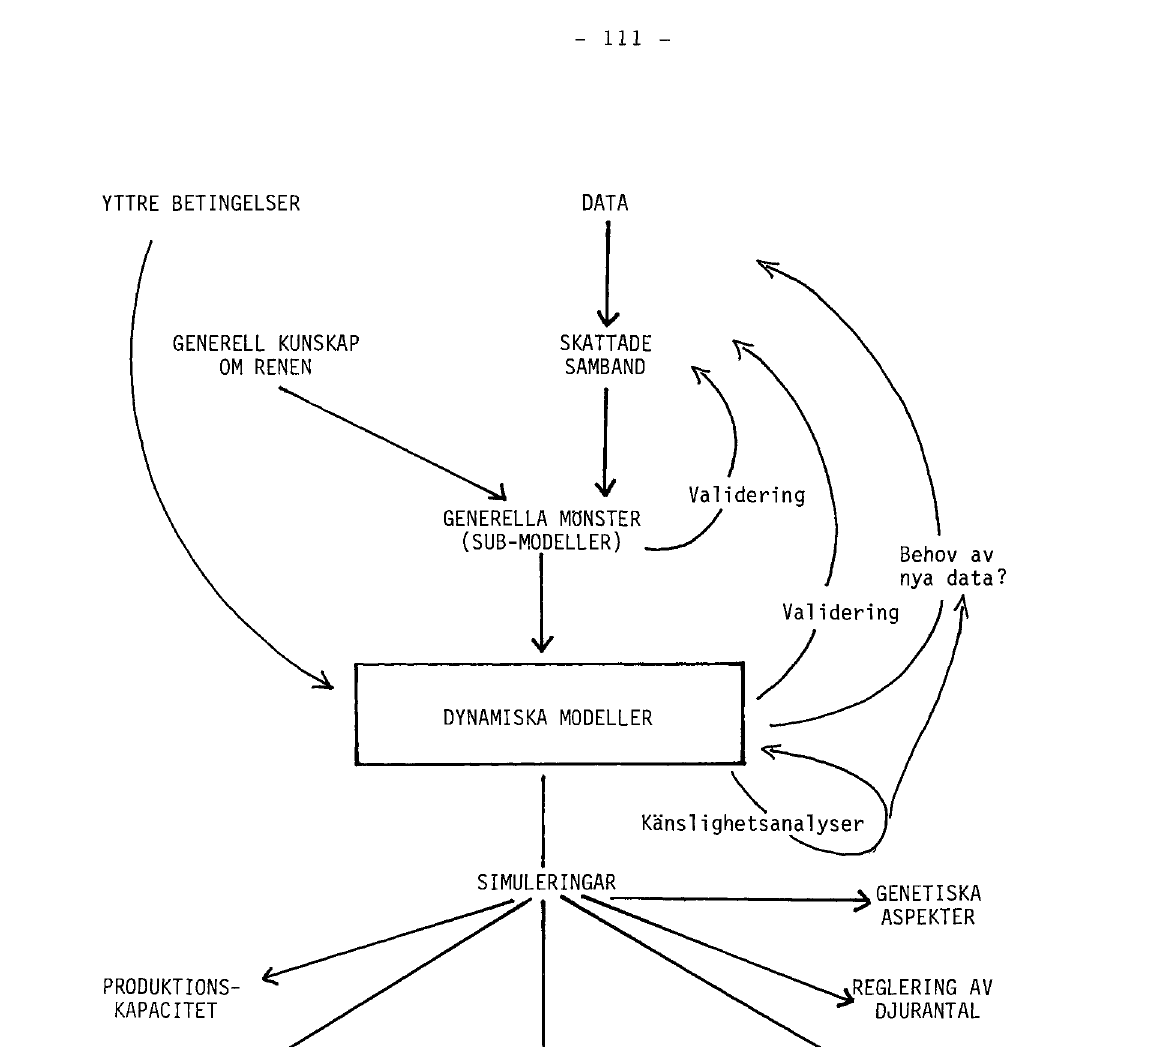
Figur 2. Systemanalytisk arbetsgång vid studier av produktionskapacitet och hjordsammansättning i